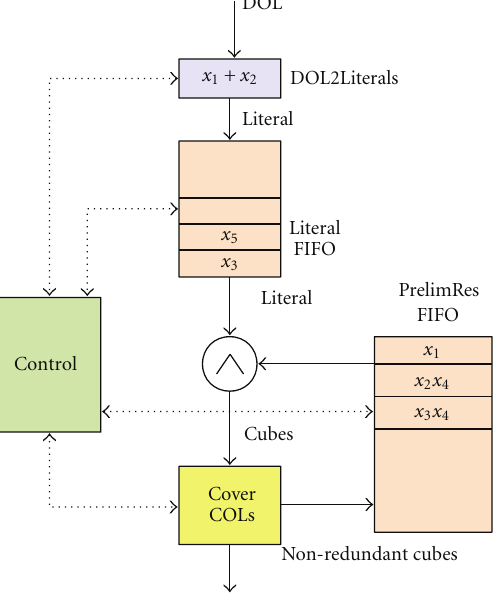
Figure 10: Illustration of a step in the conversion of CNF ( x 1 ∨ x two conjunctions have been computed and their redundant terms eliminated and stored in the Preliminary Results FIFO.